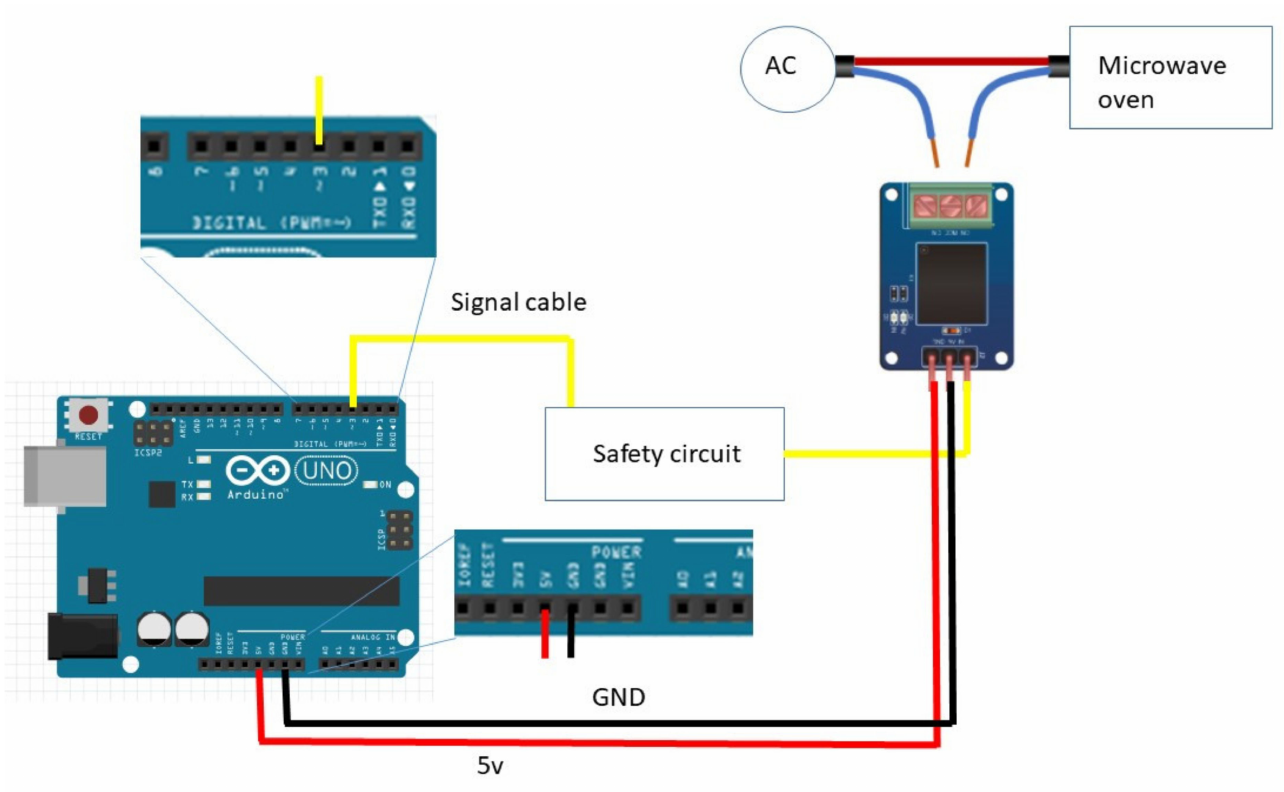
Figure 2. General connections of the complete